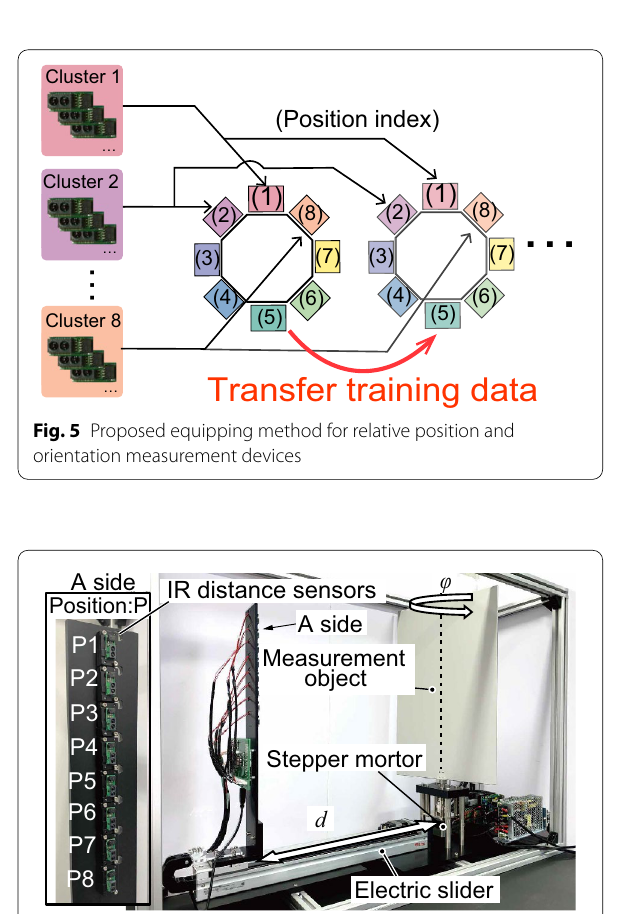
Fig. 6 Sensor output characteristics acquisition